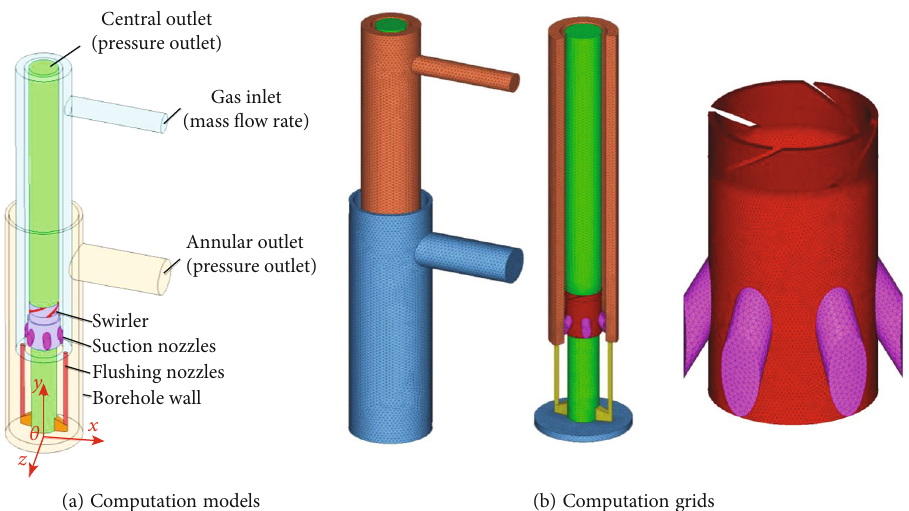
Figure 5: Geometry model and grid generation for the reverse circulation drill bit with a vane swirler built in: (a) computation models; (b) computation grids.